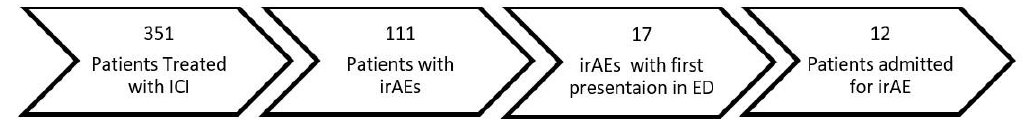
Figure 1. Pie chart for patients who received immune checkpoint inhibitors (ICI) with subsequent presentation to ED and proportion of indications for visit. Visits categorized as irAE (black) include first presentation of a new toxicity as well as presentation for complications of an already known irAE.